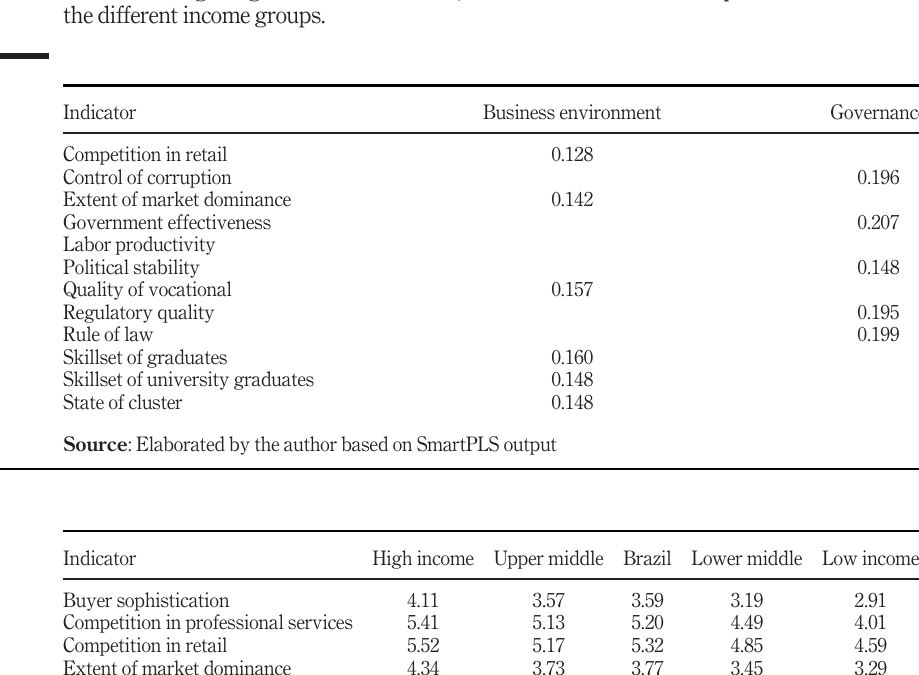
environment quality indicators (0 – 7) by countries income group versus Brazil